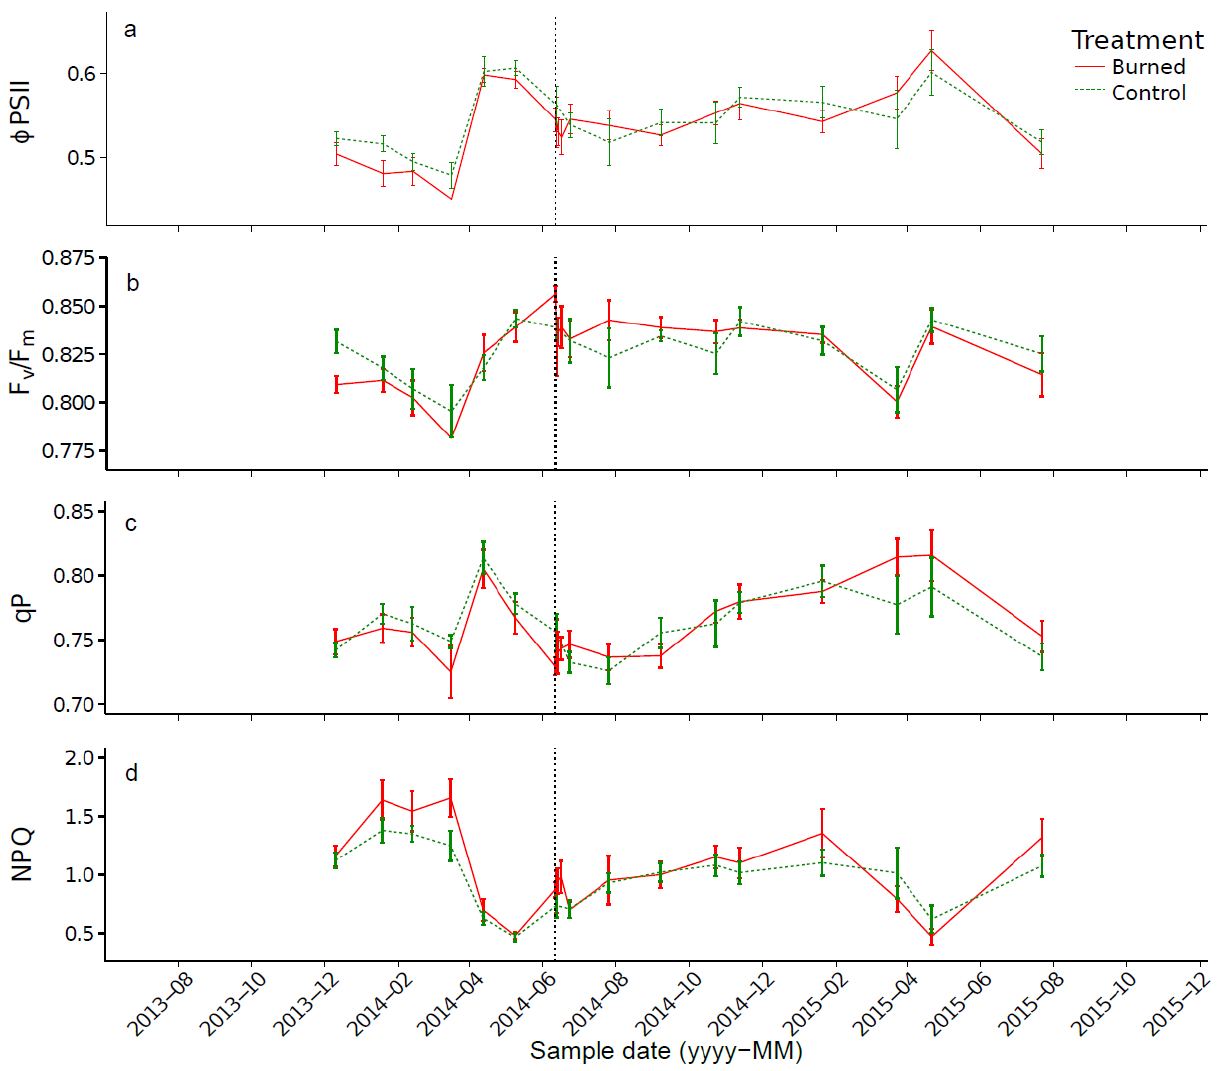
Figure 7. Mean values of Φ PSII ( a ), Fv/Fm ( b ), qP ( c ) and NPQ ( d ). Error bars represent the standard error. The vertical dashed line represents the date of the prescribed burning. Table 5. Results of treatment and date effects on chlorophyll fluorescence and gas exchange parame- ters, by two-way ANOVA (significance level p =